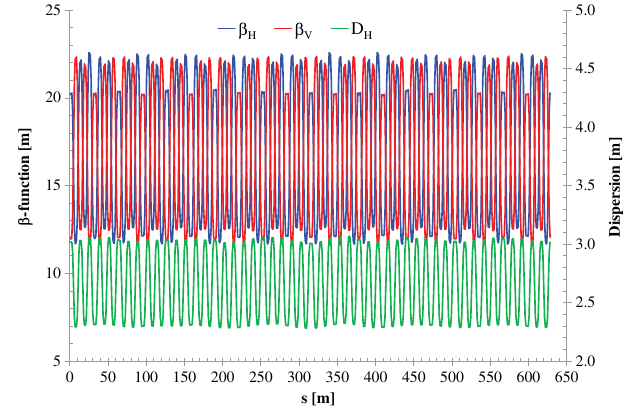
FIG. 1. Overview of the PS optics. The horizontal and vertical beta functions are shown as a function of the distance along the PS circumference, together with the horizontal dispersion. The origin of the horizontal axis is taken in straight section